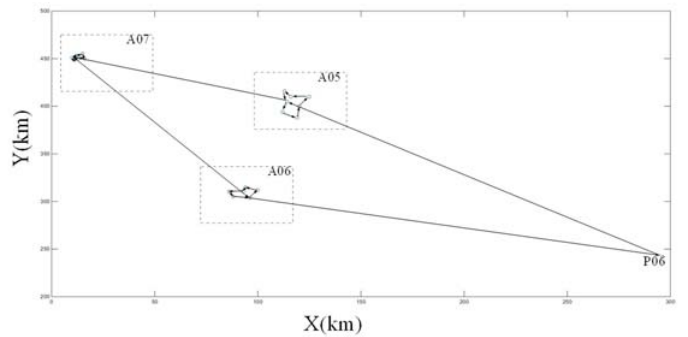
Figure 11. Local path planning for multi ‐ UAVs in the C target group.